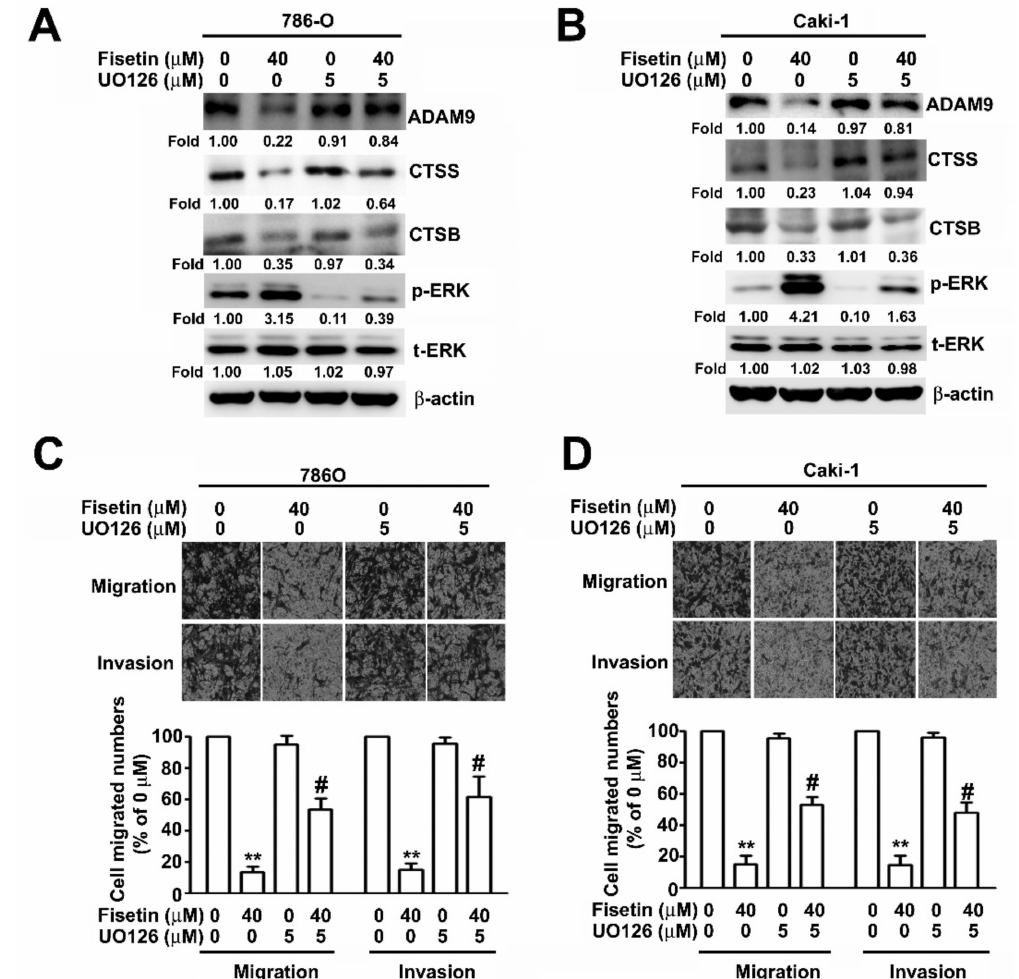
Figure 6. ERK pathways are involved in ADAM9 and CTSS regulation by fisetin. ( A , B ) 786-O and Caki-1 cells were pre-treated with UO126 (5 µ M) for 2 h and then incubated with or without fisetin (40 µ M) for 24 h. Cell lysates were subjected to Western blotting to determine the expression of ADAM9, CTSB, CTSS, p-ERK, and t-ERK proteins. β -actin was used as an internal control for protein, with equal loading. ( C , D ) Then cells were assessed for the abilities of migration and invasion. Data are presented as the mean ± SE of at least three independent experiments. ** p < 0.01 compared with the untreated control (0 µ M). # p < 0.01, compared with fisetin treatment